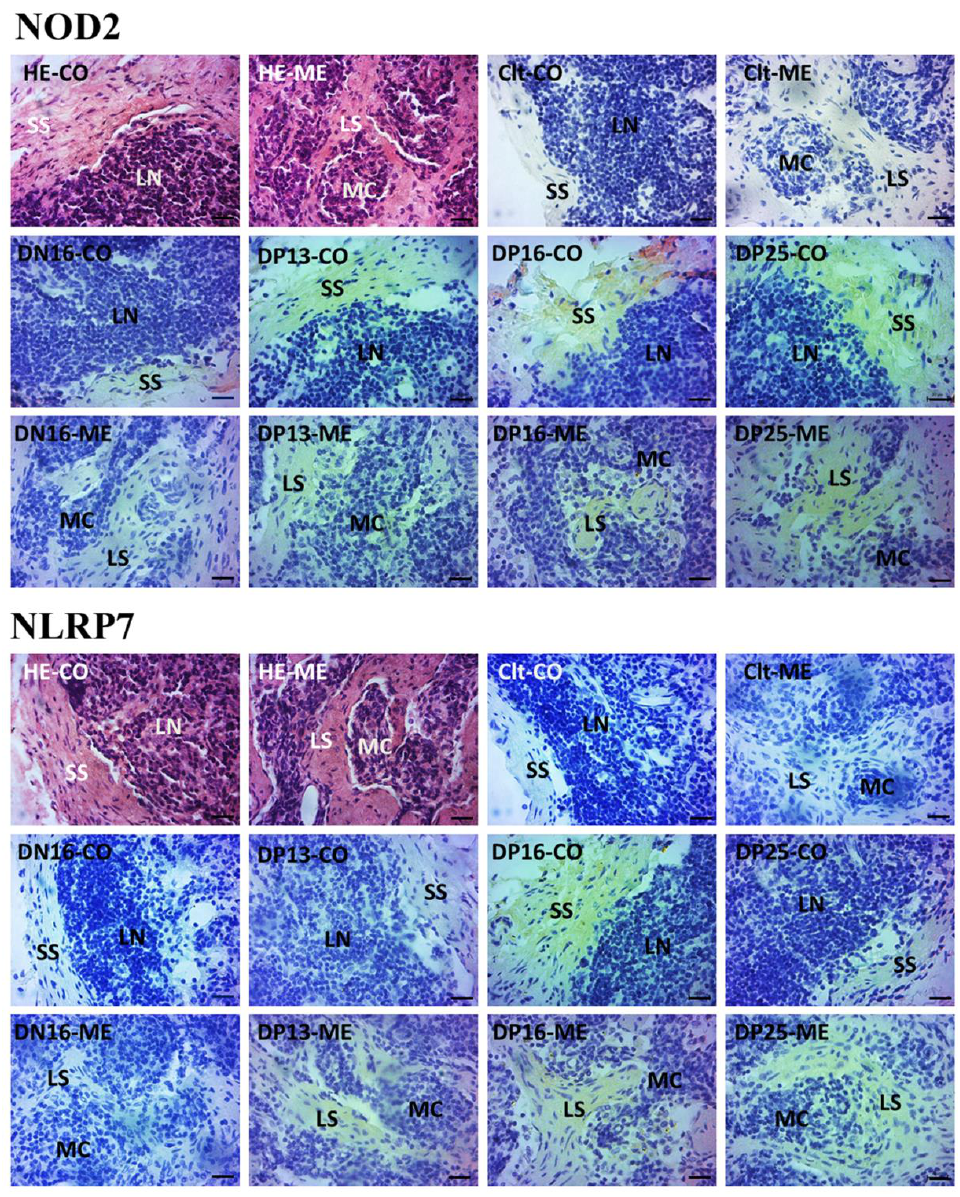
Figure 3. Representative immunohistochemical localization of NOD2 and NLRP7 proteins in the lymph nodes. The lymph node is divided into the outer cortex (CO) and the inner medulla (ME). Lymph enters the convex through the subcapsular sinus (SS) around the lymphoid nodules (LN) and flows into the medulla through the lymph sinus (LS) around the medullary cord (MC). Note: HE = stained by hematoxylin and eosin; Clt = negative control; DN16 = day 16 of nonpregnancy; DP13 = day 13 of gestation; DP16 = day 16 of gestation; DP25 = day 25 of gestation. Bar = 20 µ